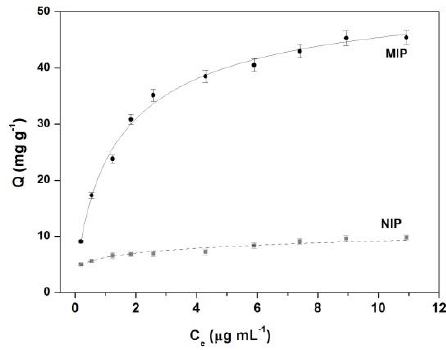
Figure 5. The adsorption isotherm and Langmuir fit of FeO x / ZnS@MIPs. Experimental conditions: Figure 5 . The adsorption isotherm and Langmuir fit of FeO x /ZnS@MIPs. Experimental conditions: citrate bu ff er solution (0.02 mol L − 1 , pH = 6.4), room citrate buffer solution (0.02 mol L − 1 , pH = 6.4), room temperature.